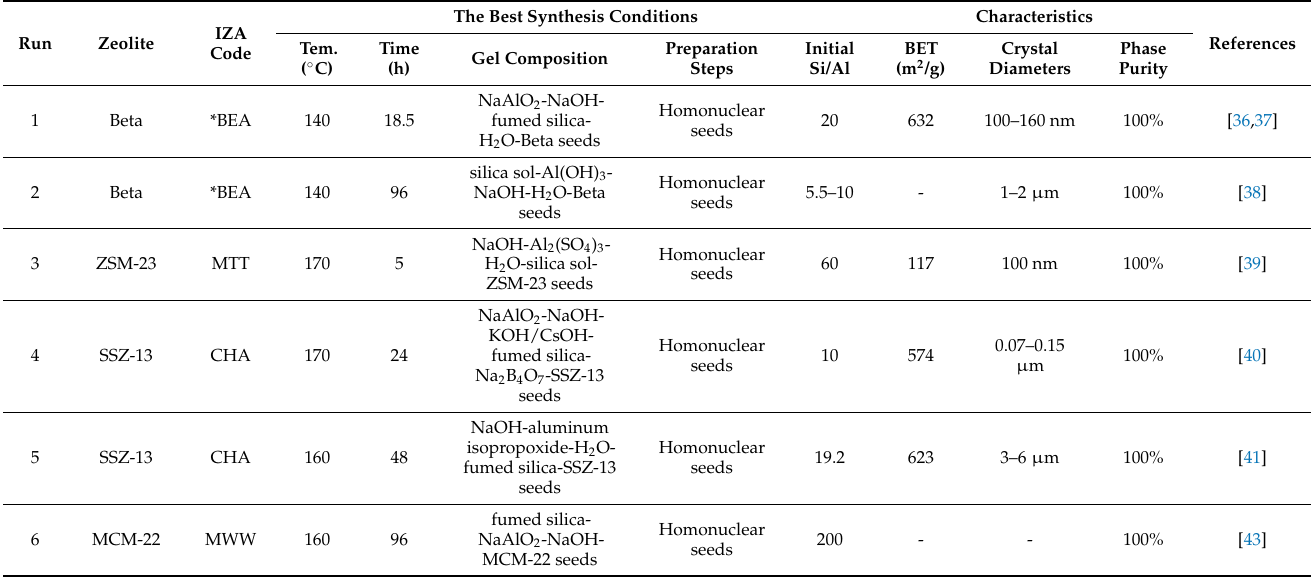
Table 2. List of zeolites prepared from the seed-directed route with optimal synthetic conditions and their key